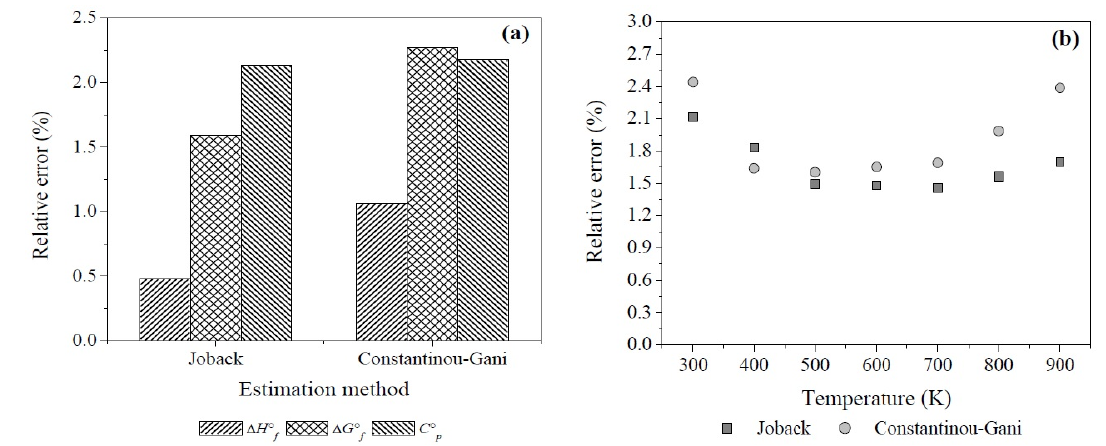
Figure A1. Comparison of relative errors of Joback and Constantinou-Gani methods for ( a ) Δ H ° and Δ G ° of formation and heat capacities at standard state and ( b ) heat capacities at different temperatures of alcohols, aldehydes, and ketones with C 2 –C 4 atoms.